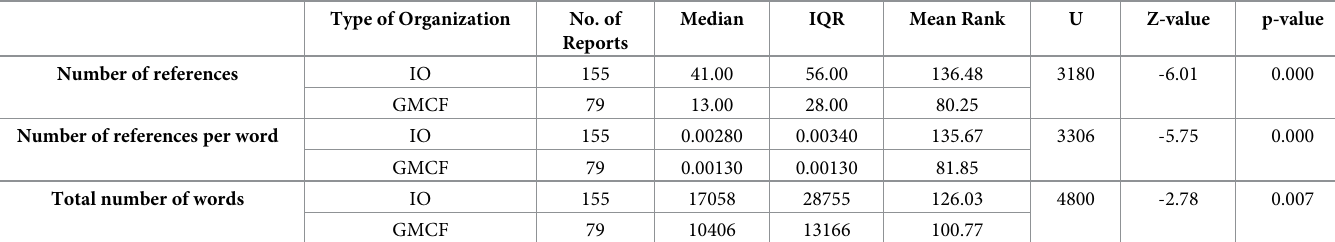
Table 2. Mann-Whitney U test of the number and references, number of references per word and total number of words across IOs and GMCFs.